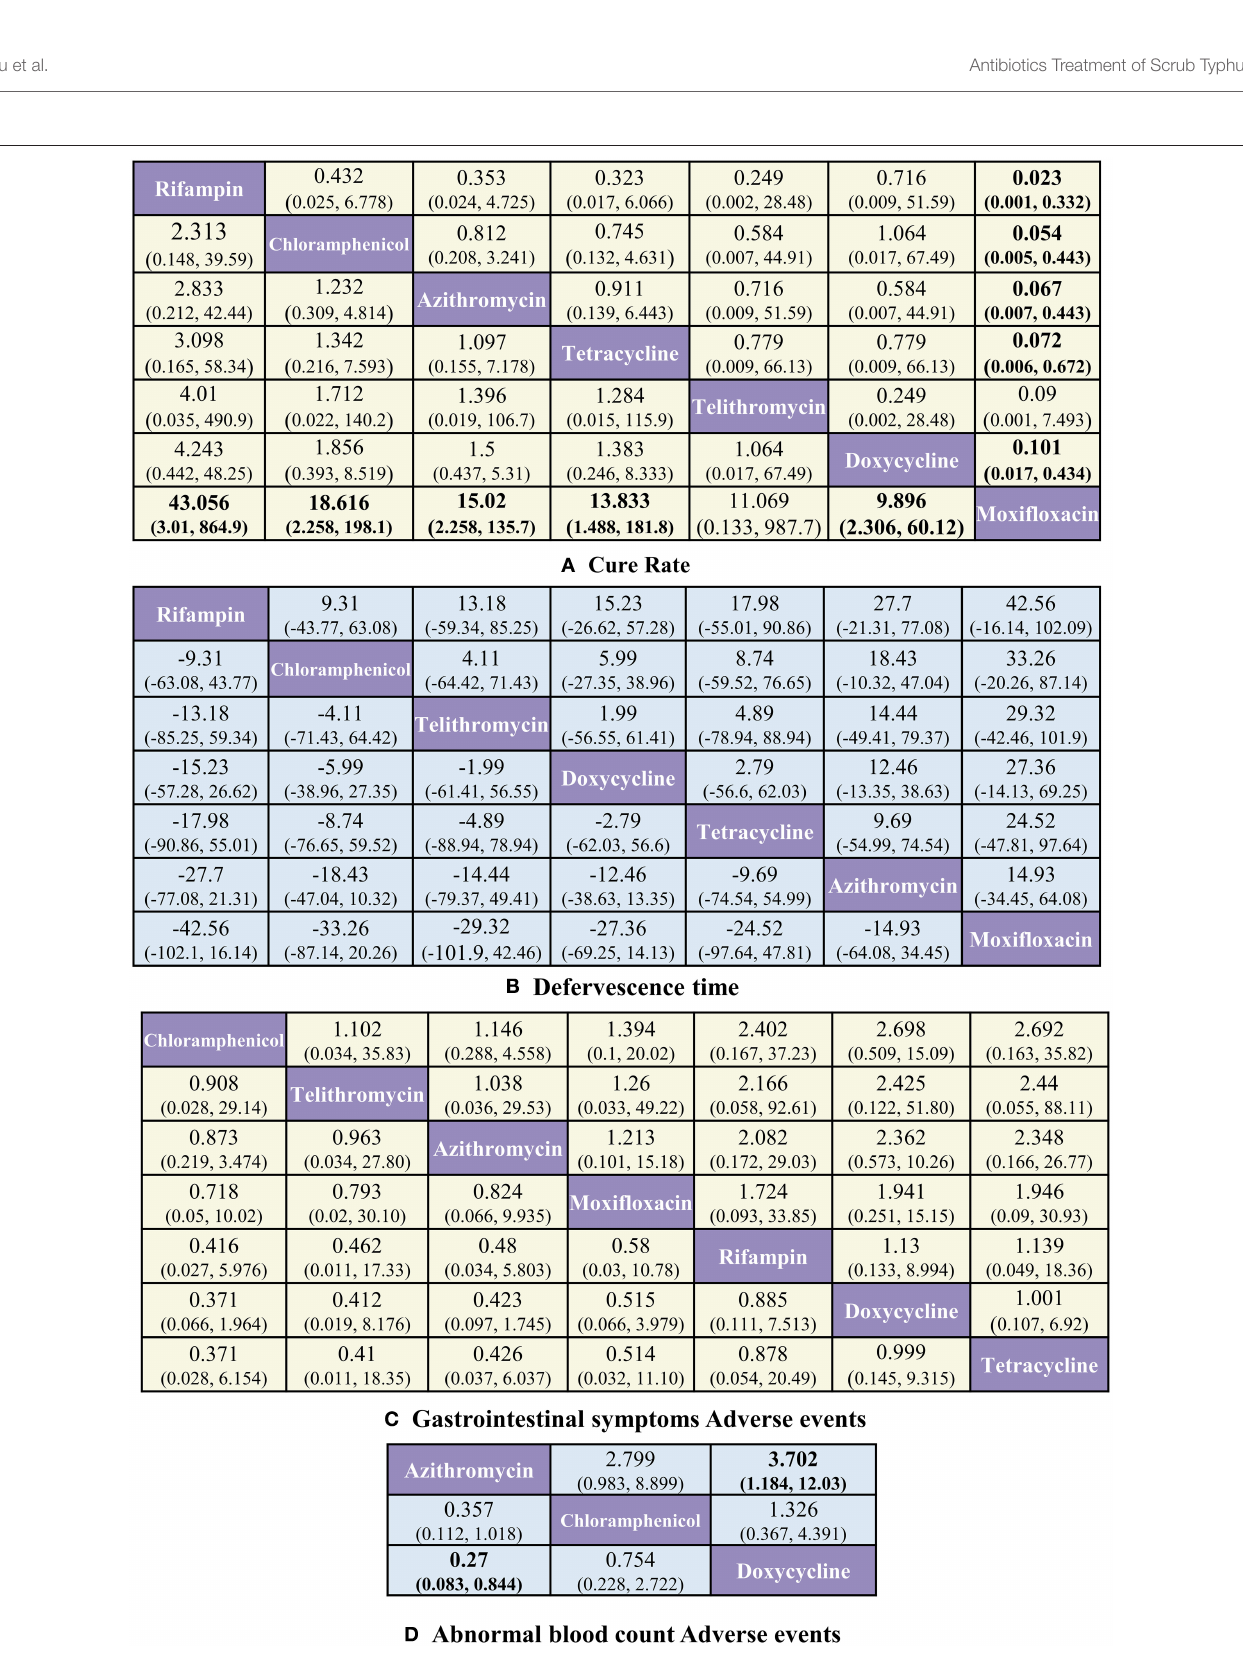
FIGURE 3 | Pooled estimates of the network meta-analysis. (A) Pooled odds ratios (95% credible intervals) for CR. (B) Pooled Mean difference (95% credible intervals) for DT. (C) Pooled odds ratios (95% credible intervals) for GS-AD. (D) Pooled odds ratios (95% credible intervals) for ABC-AD. Data in each cell are OR and MD (95% credible intervals) for the comparison of row-defining treatment vs. column-defining treatment. Significant results are highlighted in bold.